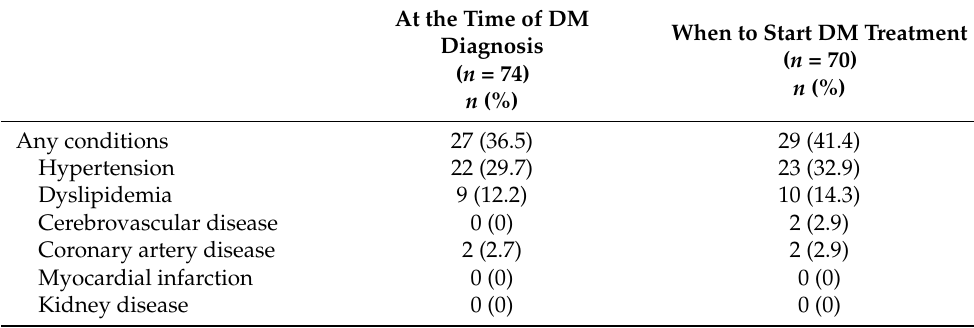
Table 5. Prevalence of comorbidity and complications of DM at DM diagnosis and